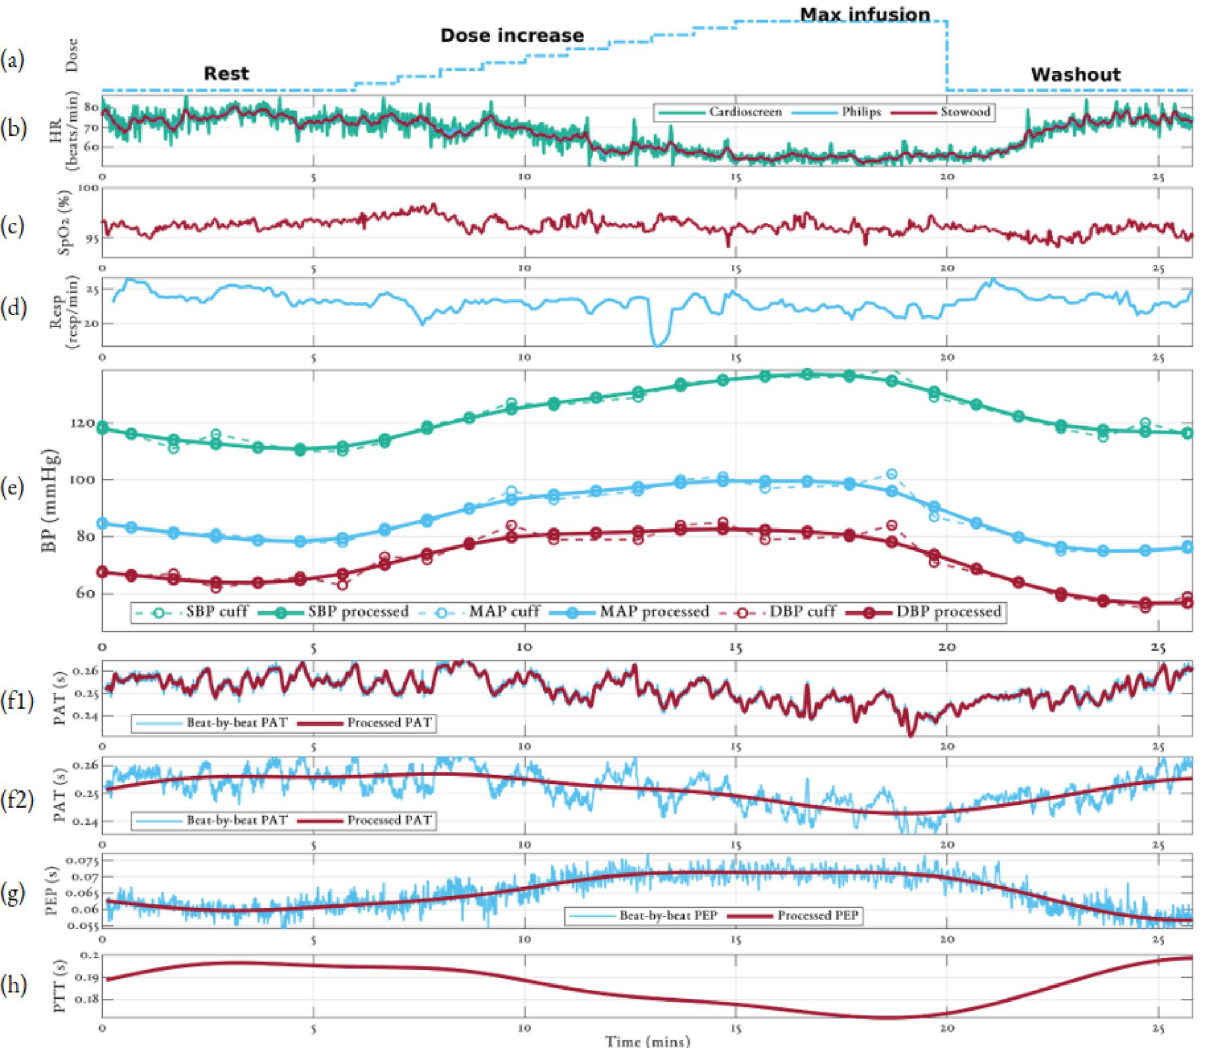
Figure 2. Physiological response for a 28 y/o female with BMI of 21.0. ( a ) Dose of phenylephrine. ( b ) Heart rate from the Cardioscreen, Philips and Stowood reference devices. ( c ) SpO 2 from the Stowood device, ( d ) respiratory rate from the nasal cannula, ( e ) BP from the cuff (dotted lines) and processed by our proposed algorithms (solid line), ( f1 ) beat-by-beat PAT and filtered PAT with respiratory component removed, ( f2 ) beat- by-beat PAT and processed PAT to compare to cuff values, ( g ) beat-by-beat PEP time series and processed PEP, and ( h ) PTT time